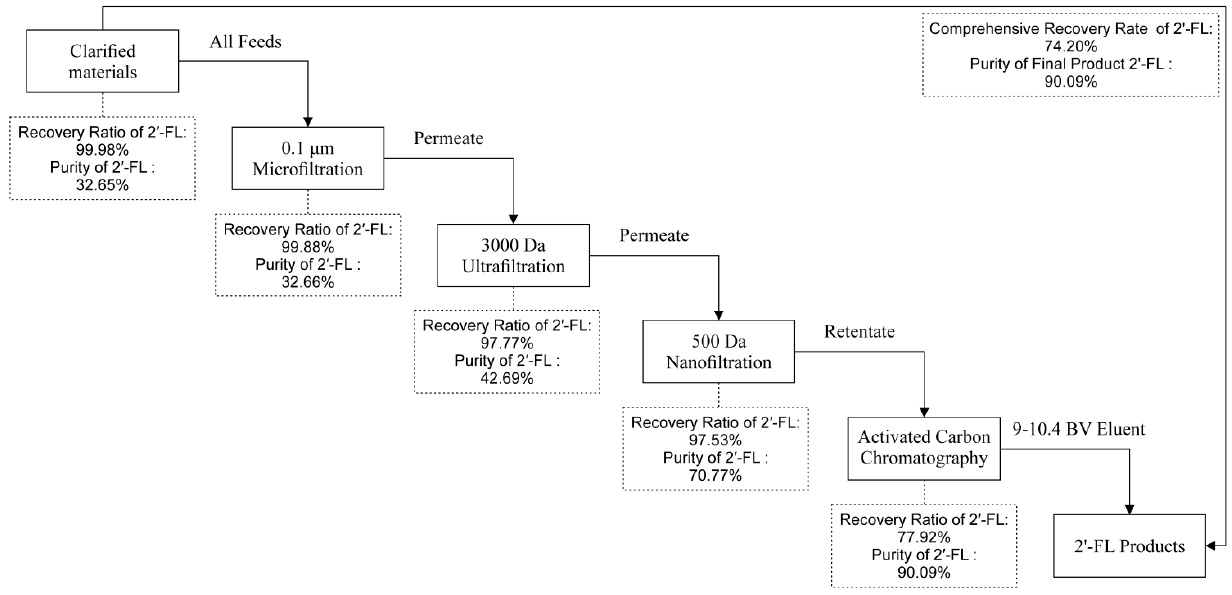
Figure 8. Flow chart of the optimal combination process and the recovery rate and product purity of 2 ′ -FL after each process treatment.